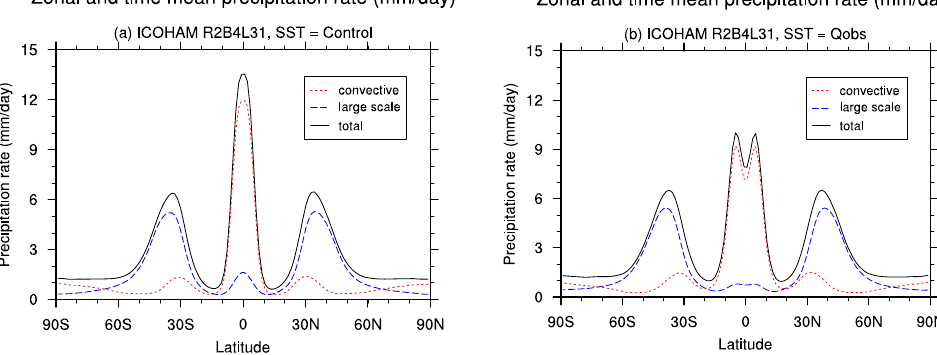
Fig. 14. Time and zonal mean surface precipitation rate (unit: mmday − 1 , solid black lines) simulated by ICOHAM in aqua-planet simulations at R2B4L31 resolution using the “Control” (left) and “Qobs” (right) SST profiles. The contributions from convective (dotted red lines) and large-scale (dashed blue lines) precipitation are also displayed. Further details can be found in Sect. 7.